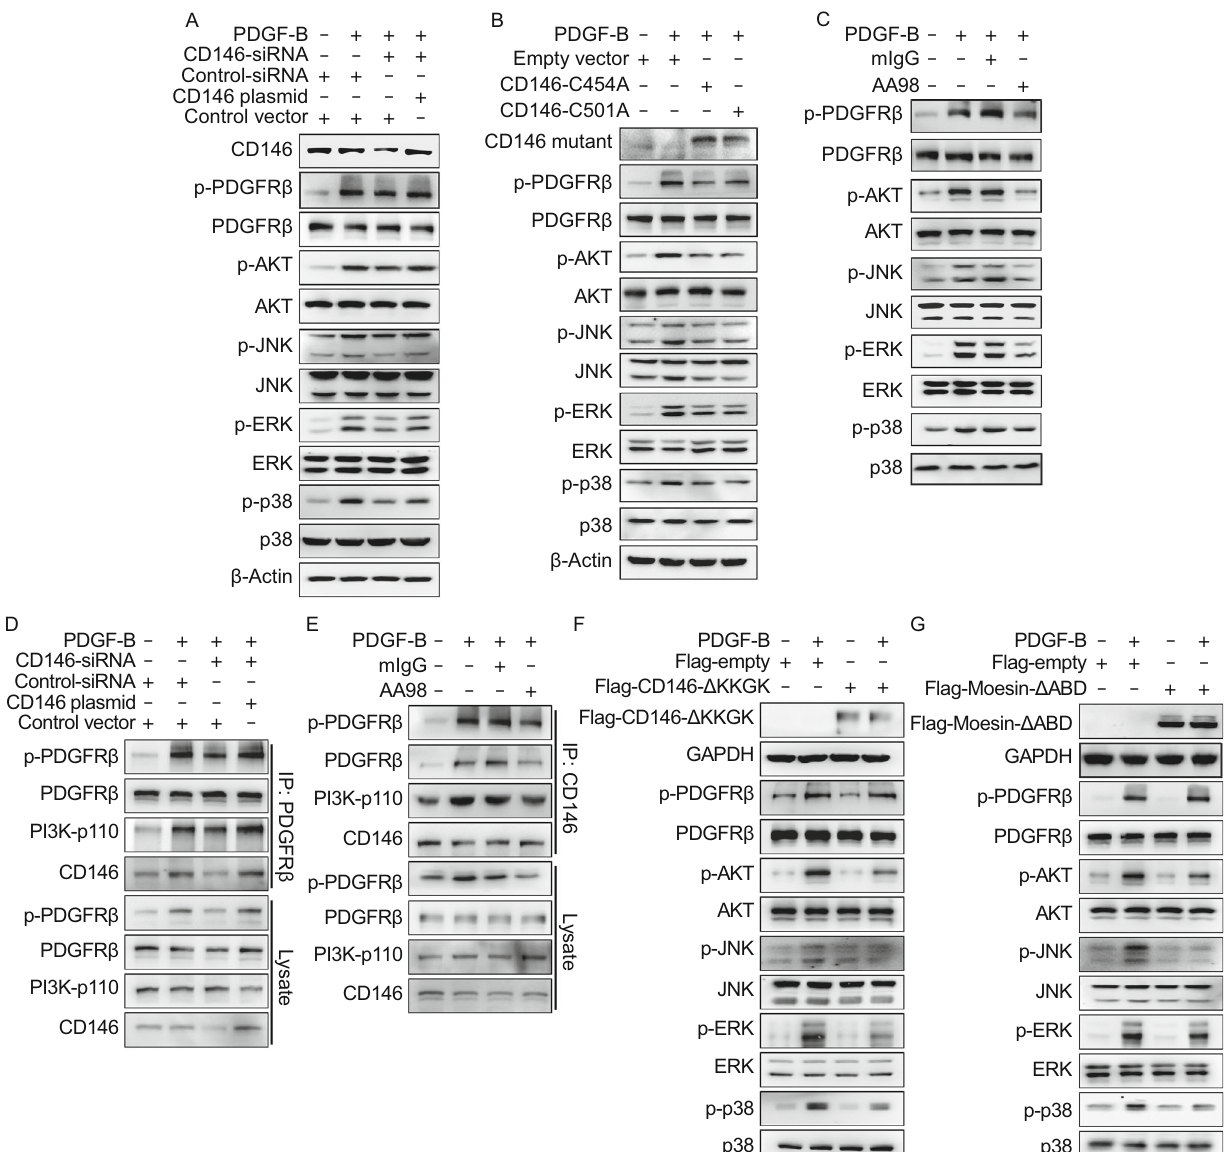
Figure 1. CD146 is required for PDGFR β -mediated signal transduction . (A) 10T1/2 cells were transfected with Cd146 -siRNA or co-transfected with Cd146 -siRNA and a Cd146 -expressing plasmid, and then stimulated with PDGF-B (20 ng/mL). CD146 expression and the activation of PDGFR β , AKT, JNK, ERK, and p38 were detected by Western blotting. (B) Cd146 / C454A or Cd146 / C501A was transfected into 10T1/2 cells and the activation of PDGFR β , AKT, JNK, ERK, and p38 induced by PDGF-B (20 ng/mL) was detected by Western blotting. (C) 10T1/2 cells were stimulated with PDGF-B (20 ng/mL) in the presence of mIgG or AA98 (50 μ g/mL). The activation of PDGFR β , AKT, JNK, ERK, and p38 was detected by Western blotting. (D) Co-immunoprecipitation (Co-IP) of endogenous CD146, PDGFR β , p-PDGFR β , and p110 induced by PDGF-B (20 ng/mL) was measured after the transfection of 10T1/2 cells with Cd146 -siRNA or co-transfection with Cd146 -siRNA and a Cd146 -expressing plasmid. (E) 10T1/2 cells were stimulated with PDGF-B (20 ng/mL) in the presence of mIgG or AA98 (50 μ g/mL). The interactions among endogenous CD146, PDGFR β , p-PDGFR β , and p110 were detected by Co-IP. (F) Cd146- Δ KKGK was transfected transiently into 10T1/2 cells and the activation of PDGFR β induced by PDGF-B in addition to AKT, JNK, ERK, and p38 signaling was analyzed by western blotting. (G) Moesin- Δ ABD was transfected transiently into 10T1/2 cells and the activation of PDGFR β after induction with PDGF-B in addition to AKT, JNK, ERK, and p38 signaling was examined. Data represent three independent